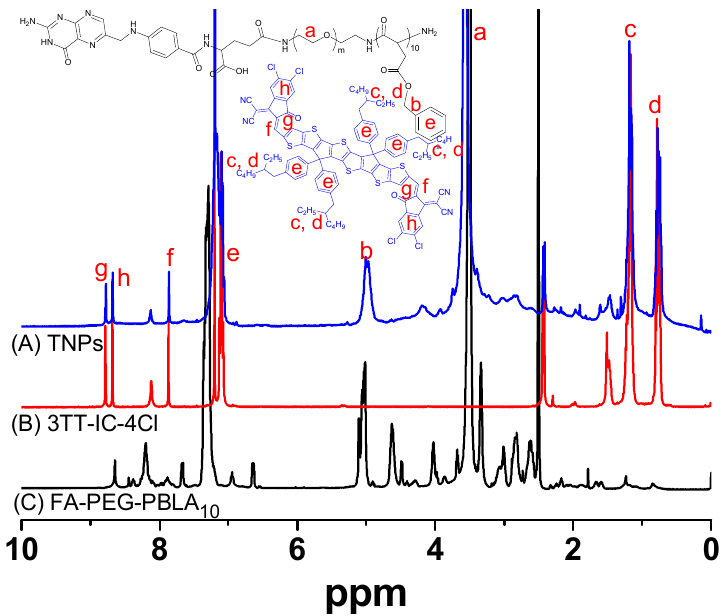
Figure 2. 1 H NMR spectra of ( A ) TNPs, ( B ) 3TT-IC-4Cl, and ( C ) FA-PEG-PBLA 10 .